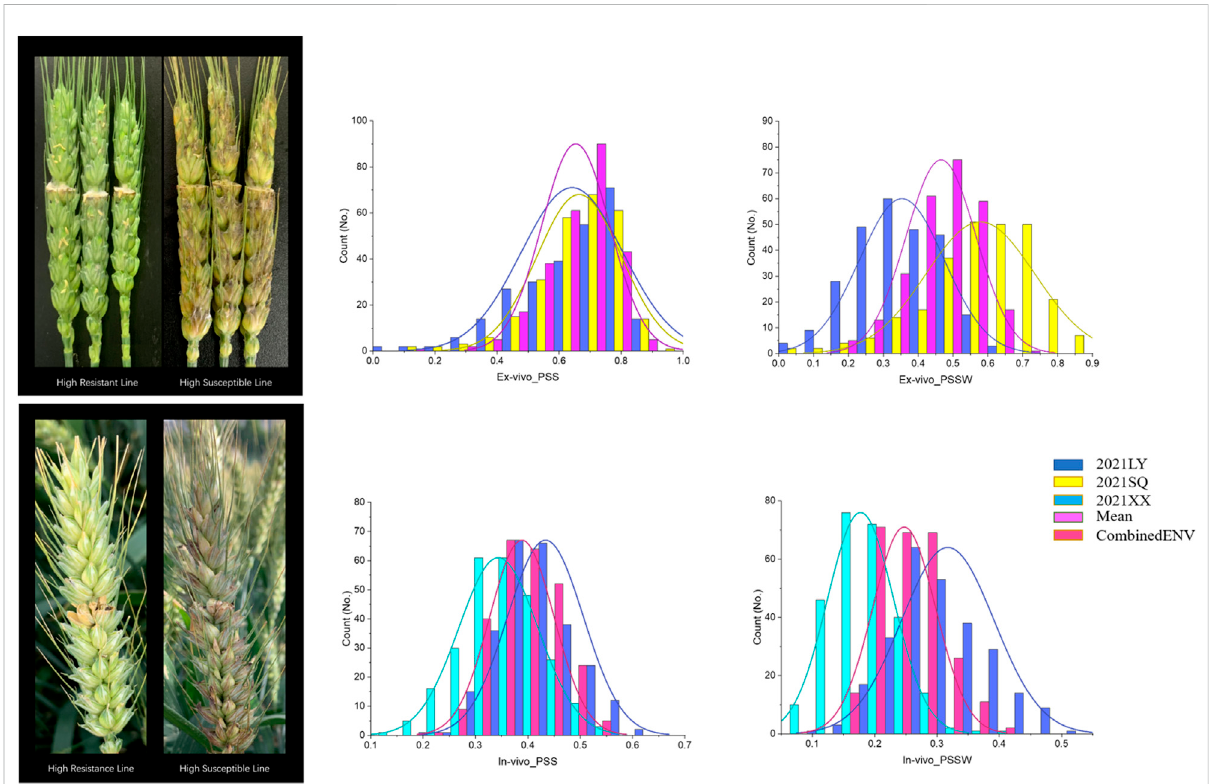
FIGURE 2 The highest resistant and susceptible lines and the distribution for PSS and PSSW of in the ZM 578/JM 22 population in each